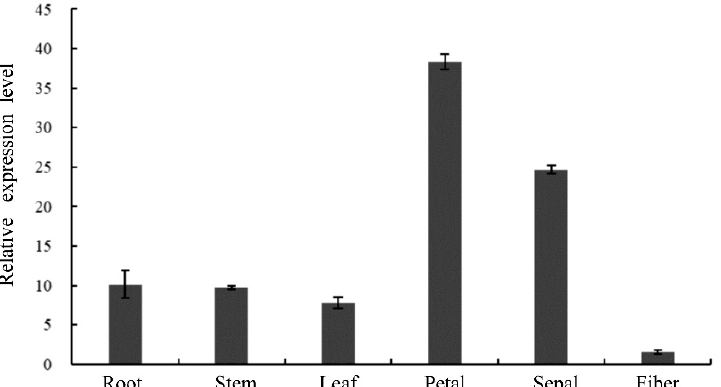
Figure 6. Expression pattern analysis of GhCIPK23 gene in different tissues of upland cotton. The error bars represent standard errors of three independent repetitions. error bars represent standard errors of three independent repetitions. 2.7. Analysis of the Response of GhCIPK23 Gene to Different Abiotic Stresses and ABA